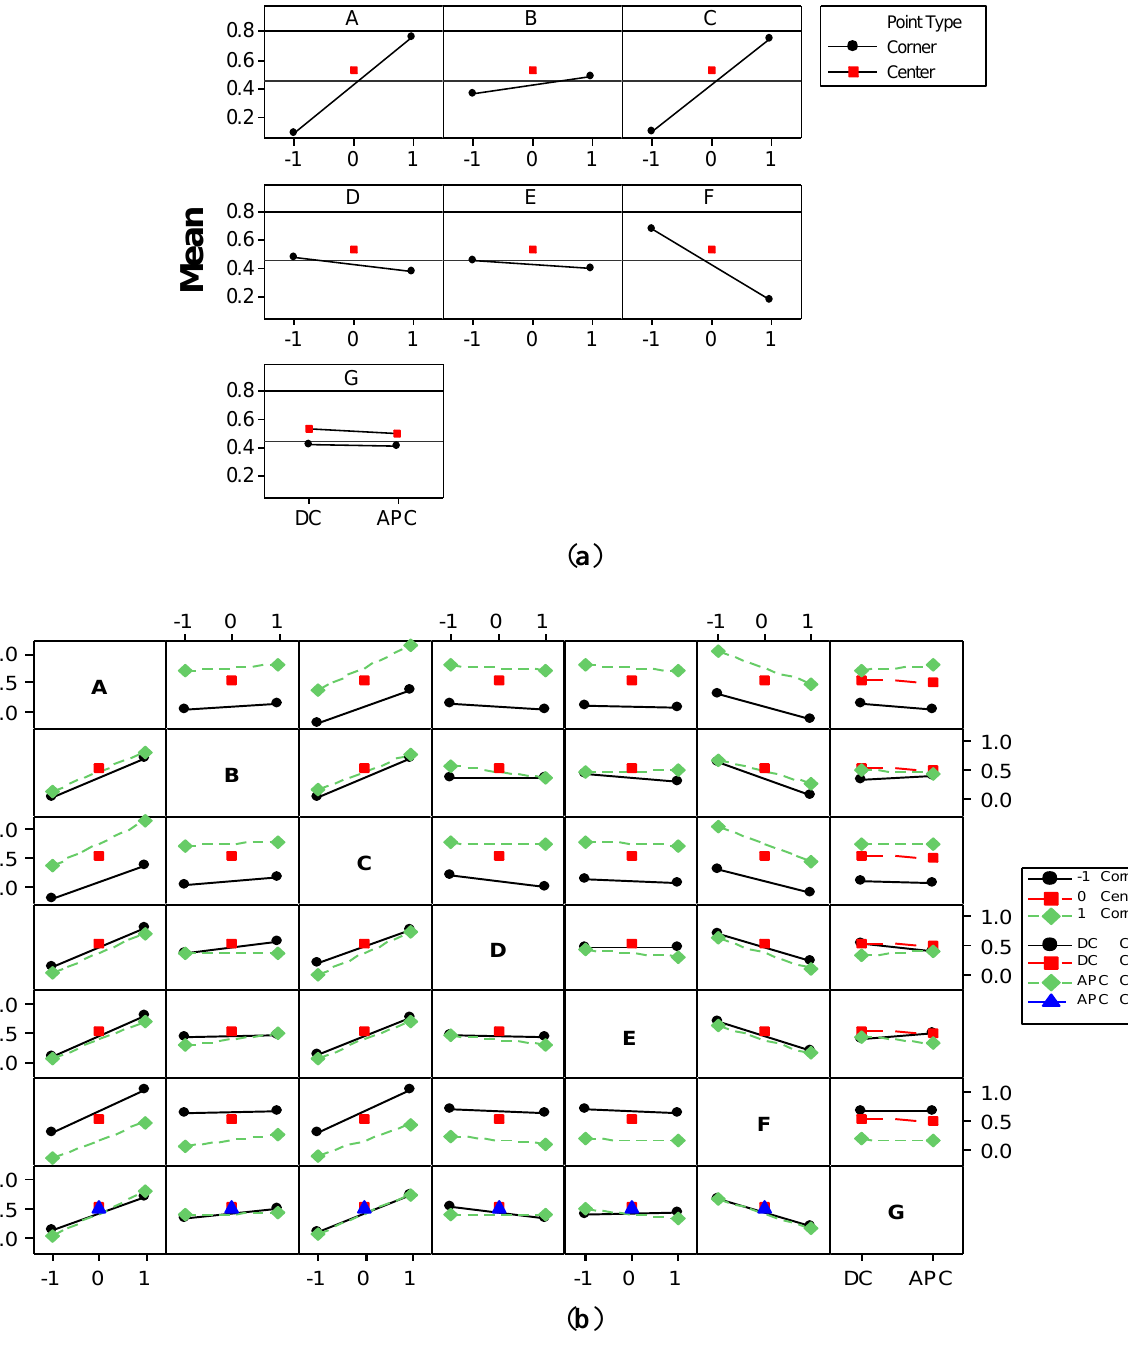
Figure 13. ( a ) Main effects; and ( b ) interaction plots for the effects on UEMD response. Solid lines represent low black levels (−1 and DC ) of the factors; dashed green lines represent high levels (1 and APC ); dashed red lines represent the center levels (0); left ends of the lines in each plot means low level of underlying factors and the right ends depict the higher